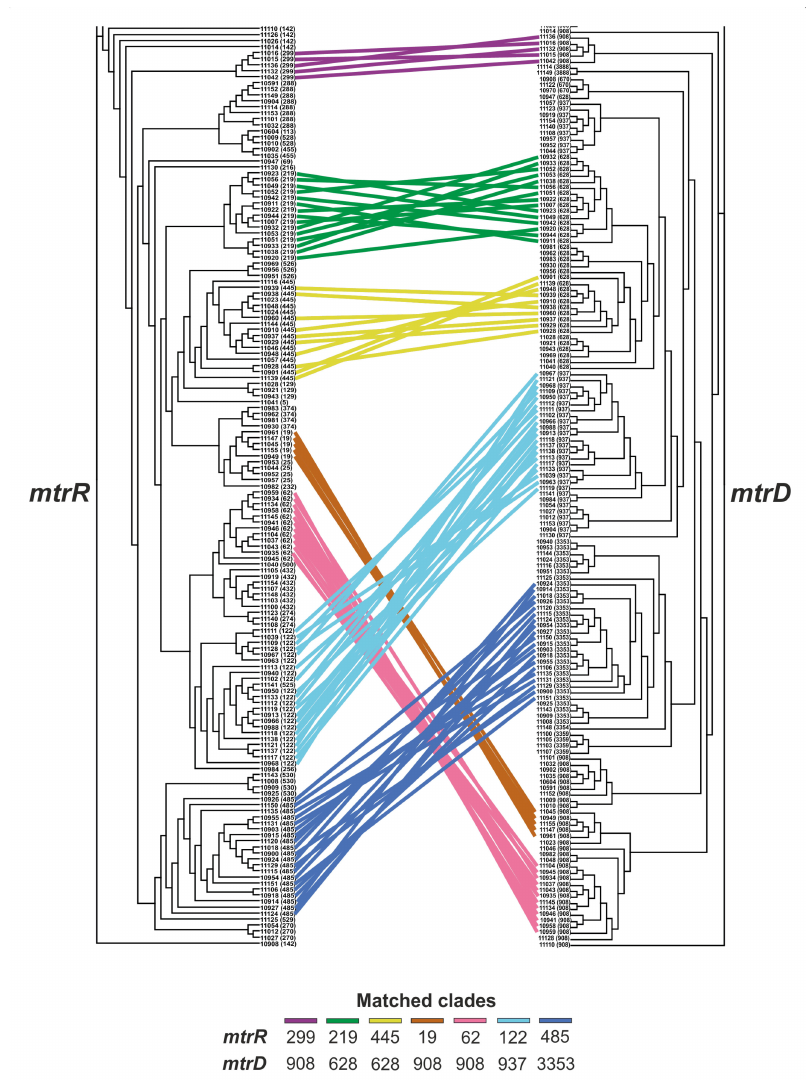
Figure 2. Correspondence between mtrR and mtrD cladograms constructed independently for the Russian N. gonorrhoeae isolates collected in 2020–2021. Sample numbers and the mtrR or mtrD allele numbers are indicated on the branches. Matched clades are formed by linked leaves of the phylogenetic tree. Matched clades consisting of five or more isolates are painted in different